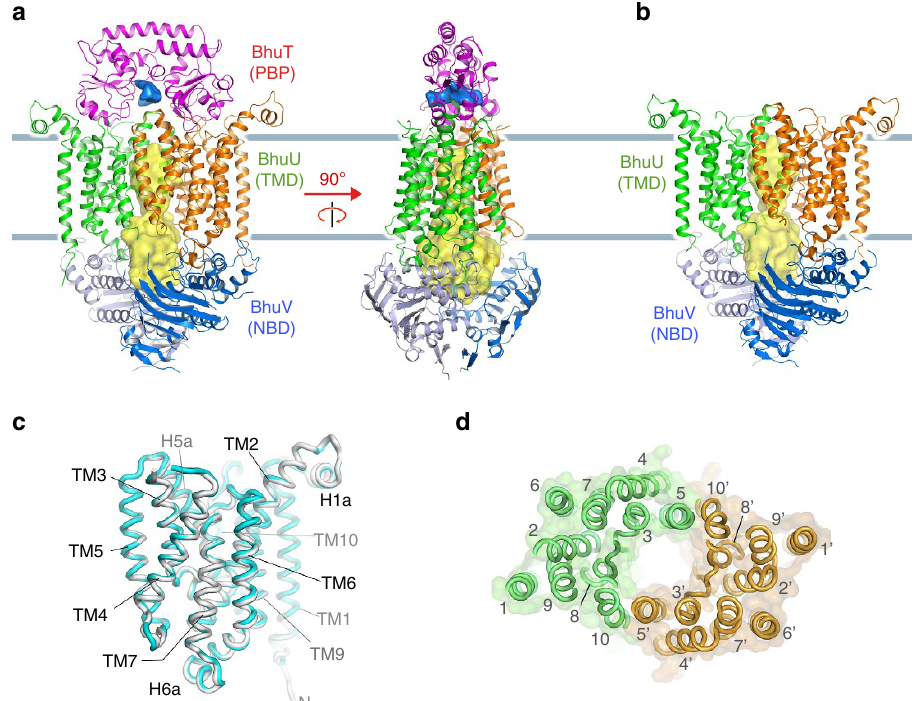
Figure 1 | Crystal structures of the type II ABC haem transporters BhuUV-T and BhuUV. ( a ) Overall structure of the nucleotide-free form of B. cenocepacia haem transporter BhuUVcomplexed with BhuT. Each subunit is shown in a different colour. The large cavity of BhuUVopen to the cytoplasm is represented by a yellow surface. The small cavity of BhuT in the haem-binding site open to the periplasm is shown as a blue surface. In the right panel, BhuUV-Twas rotated by 90 (cid:2) about the vertical axis. ( b ) Overall structure of nucleotide-free BhuUV. ( c ) Superposition of the BhuU monomer of BhuUV-T (grey) and BhuUV (cyan). ( d ) Arrangement of the transmembrane helices of BhuU dimer viewed from periplasmic side along the two-fold dimer